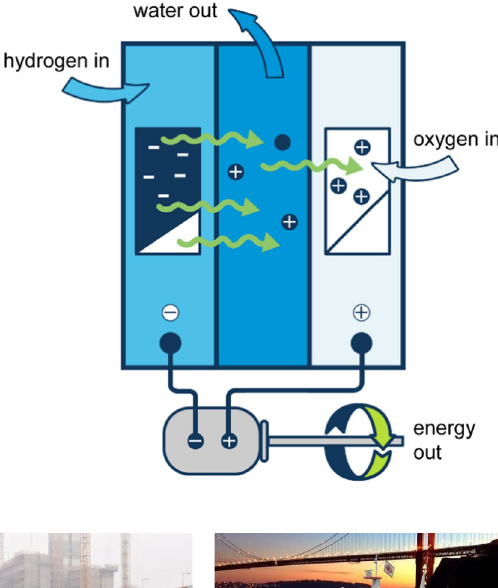
Fig. 14 Hydrogen-powered vessel. a Energy Observer (www. marine- insig ht. com). b Nemo H2 (www. vloot schouw. nl). c SF BREEZE (www. marit ime- execu tive.